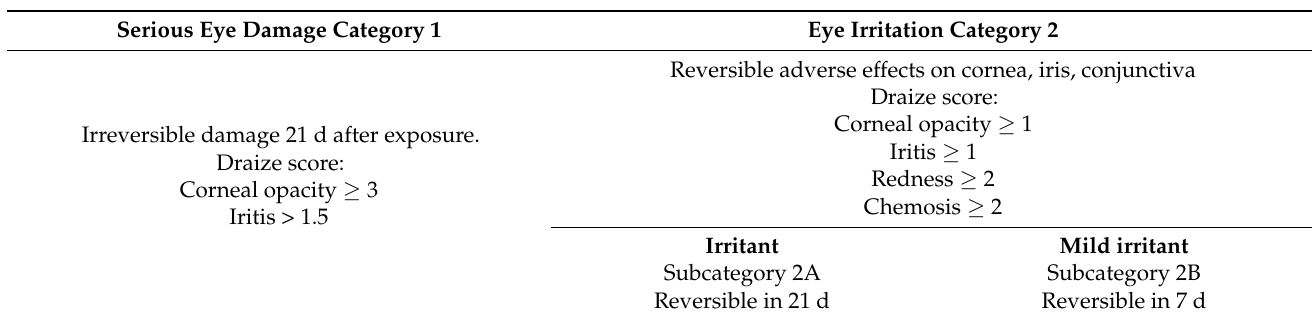
Table 3. Eye effects.